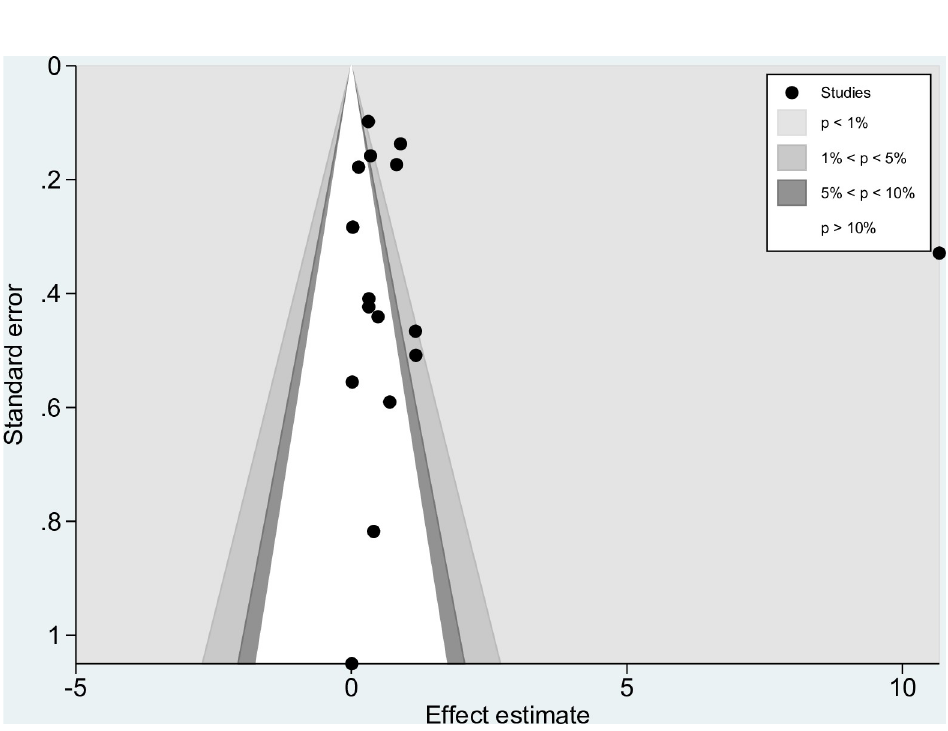
Fig 9. The contour-enhanced funnel plot demonstrated that the effect estimates were in both significant ( P < 1%, 1% < P < 5%) and non-significant areas (5% < P < 10%, P > 10%).